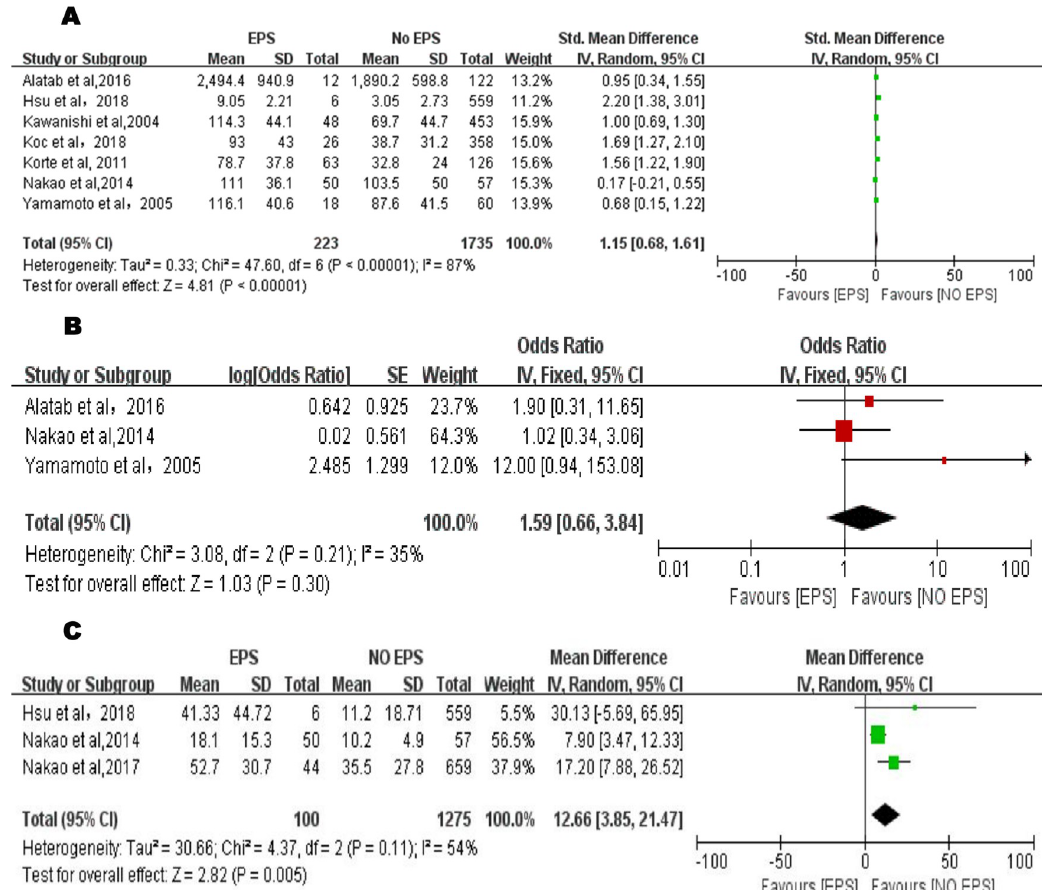
Fig 3. A. Forest plot of PD duration and EPS in the exploratory meta-analysis. The standard mean difference and 95% CI for each study and the final combined results are displayed numerically on the left and graphically as a forest plot on the right. B. Forest plot of number of peritonitis episodes and EPS in the exploratory meta-analysis. The odds ratio and 95% CI for each study and the final combined results are displayed numerically on the left and graphically as a forest plot on the right. C. Forest plot of peritonitis duration and EPS in the exploratory meta-analysis. The mean difference and 95% CI for each study and the final combined results are displayed numerically on the left and graphically as a forest plot on the